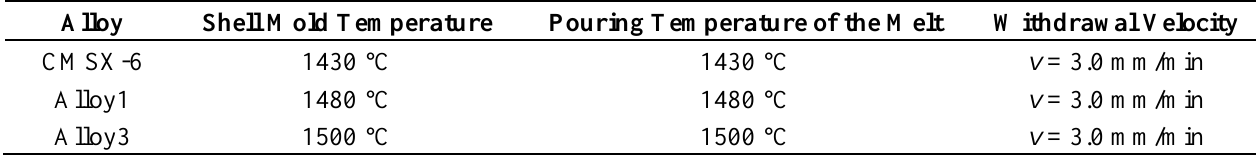
Figure 3. ( a ) Wax model of the components with platform dimensions of 15 mm, 20 mm and 30 mm; ( b ) Shell mold for single crystal solidification; ( c ) Schematic illustration of the curved liquidus isotherm in a Bridgman furnace with the shadow effect to the center column of the shell mold [7]. Table 2. Applied process parameters for the SX